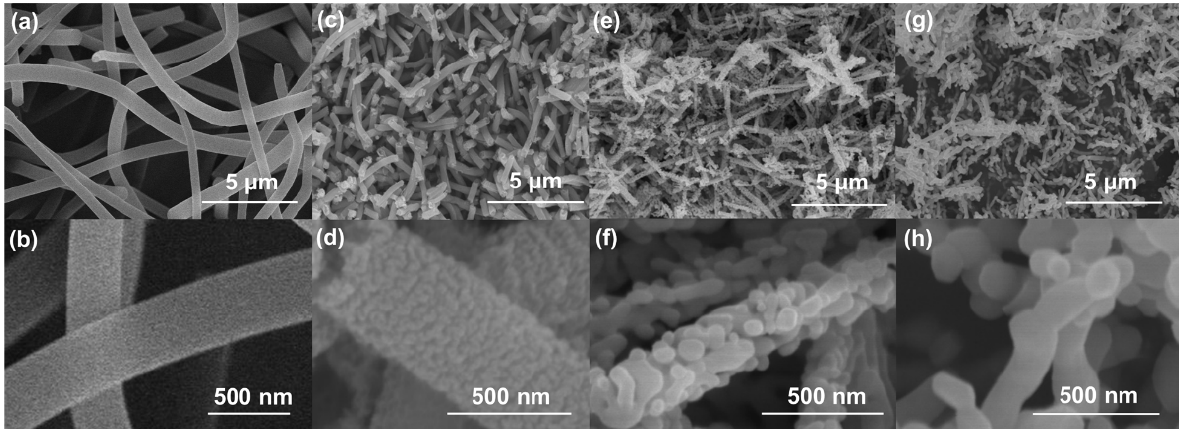
Figure 1. SEM surface images of ( a , b ) as-spun polymeric nanofibers and α -Fe 2 O 3 nanofibers annealed at ( c , d ) 300 °C, ( e , f ) 500 °C, and ( g , h ) 700 °C.